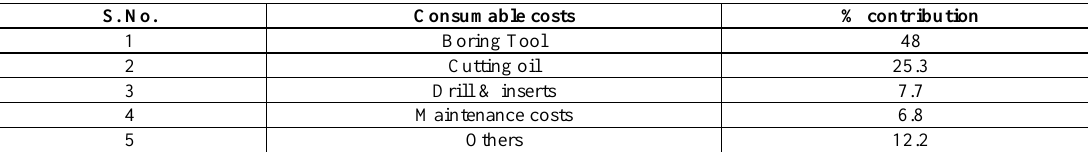
Table 1. Percentage contribution of rejection due to various points